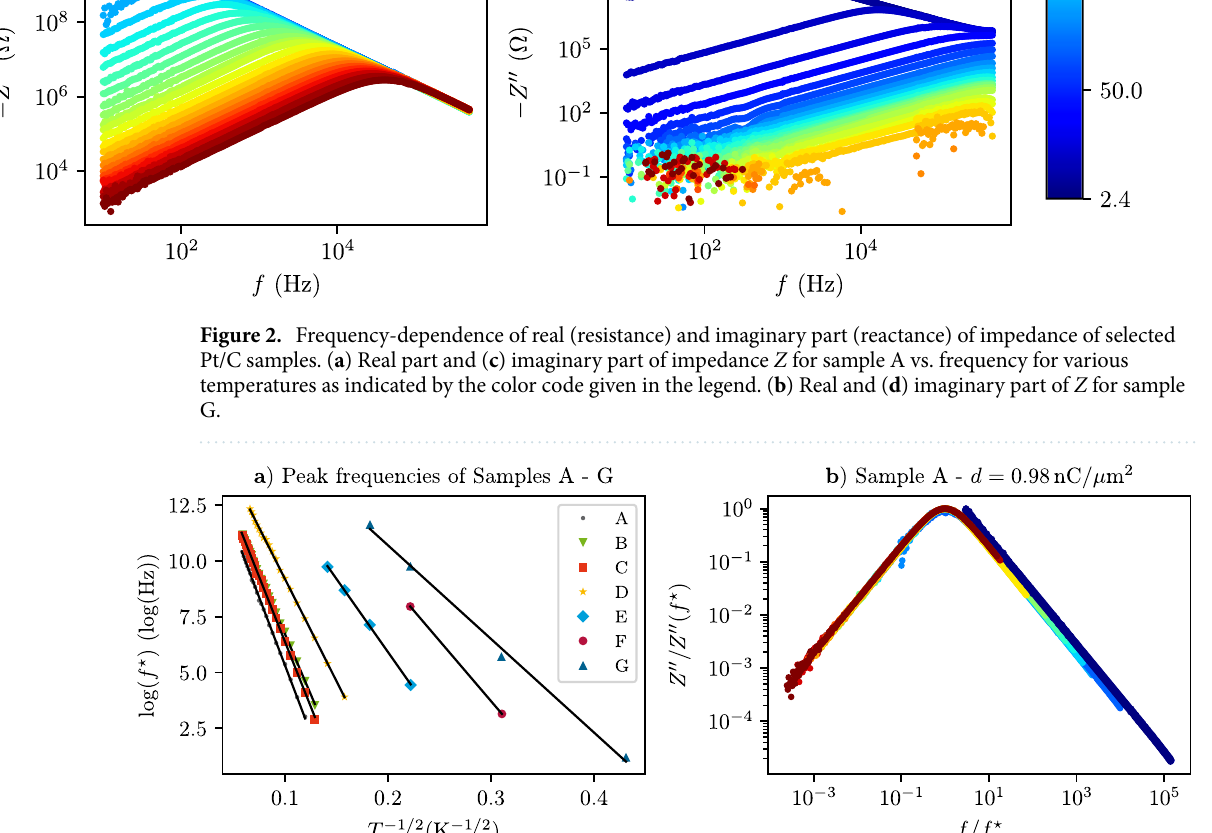
√ T representation for